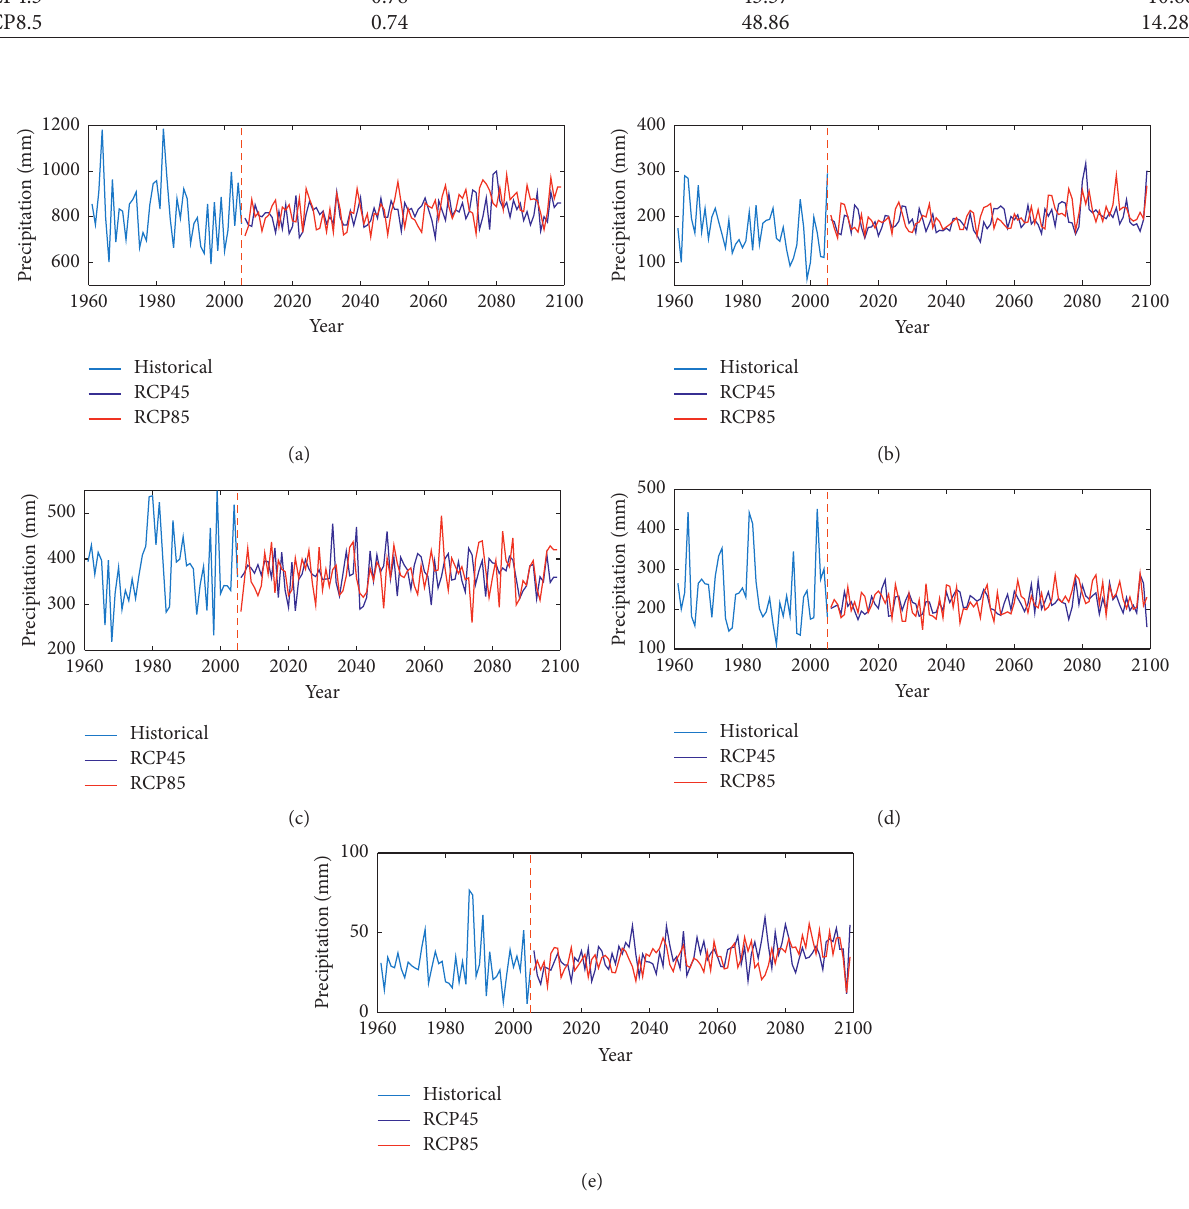
Figure 11: Yearly historical and projected precipitation under RCP4.5 and RCP8.5: (a) year, (b) spring, (c) summer, (d) autumn, and (e) winter, respectively. Horizontal axes represent the year, and vertical axes represent the rainfall